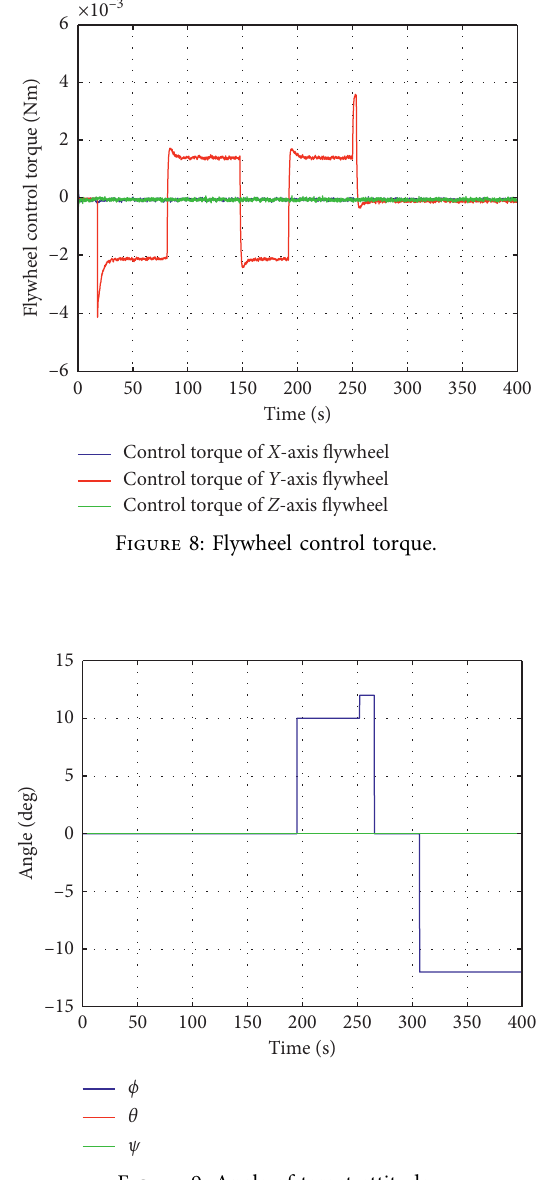
Figure 9: Angle of target